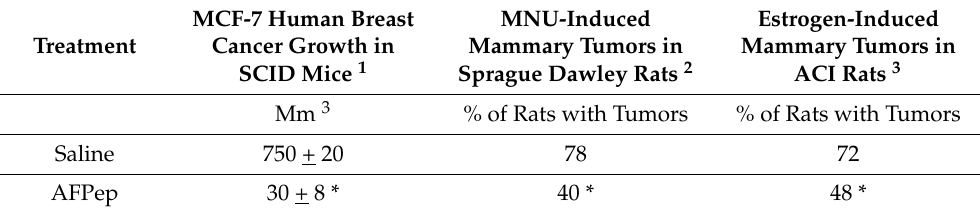
Table 1. The therapeutic and preventive efficacy of AFPep * in rodent models of mammary cancer. Estrogen-Induced MNU-Induced MCF-7 Human Breast Mammary Tumors in Mammary Tumors in Treatment Cancer Growth in ACI Rats 3 Sprague Dawley Rats 2 SCID Mice 1 Mm 3 % of Rats with Tumors % of Rats with Tumors Saline 750 + 20 78 72 AFPep 30 + 8 * 40 * 48